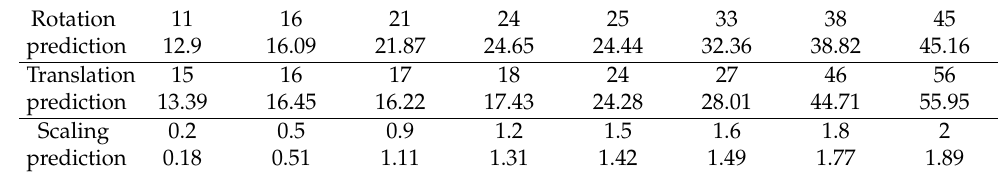
Table 8. It can be seen from Table 8 that BER is very small, which indicates the watermark can be be almost completely extracted after correction. Table 7. The MLS–SVR prediction performance for test image. Rotation